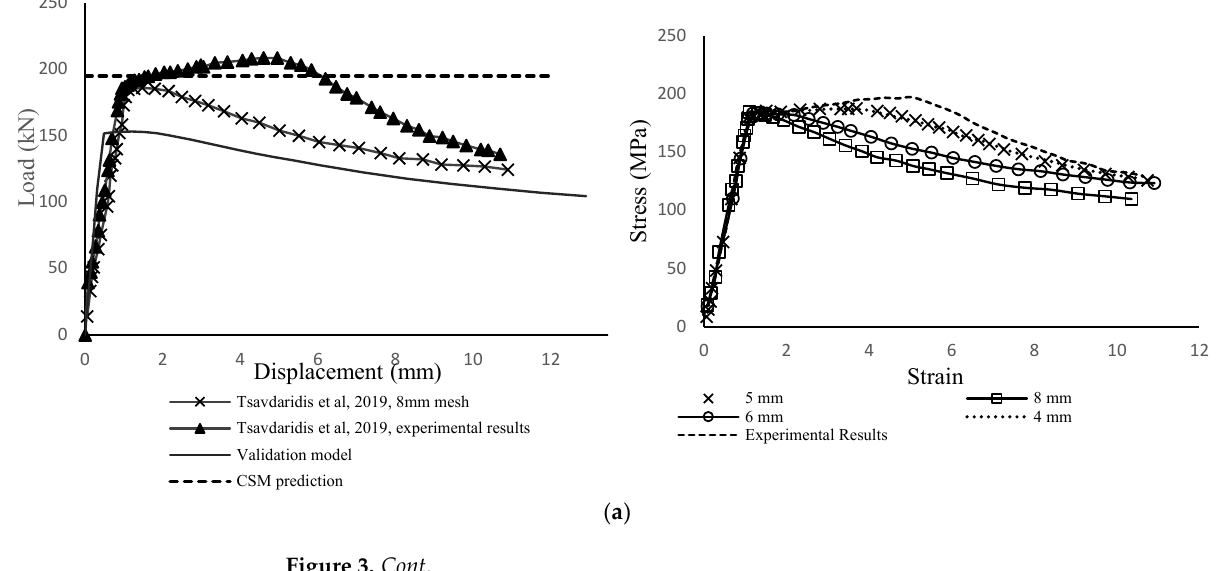
( b ) Figure 3. Validation analyses: ( a ) load – displacement curves — SV1 ( left ), load – displacement curves for various mesh sizes [1] ( right ). ( b ) Stress – strain curve — SV1 (up), stress – strain curve — SV2 (down). For the CSM predictions, the equations that were used, as given by Su et al. [16], are provided below. Initially, the cross-section slenderness, λ p , was determined. The cross- section slenderness is a non-dimensional form acquired by the square root of the ratio of the yield stress f y to the elastic buckling stress σ cr of the cross-section, as can be seen in Equation (1). All the cross-sections investigated in this paper were non-slender, since their cross-section slenderness, λ p , was lower than 0.68. In this study, the elastic buckling stress was calculated through a formula acquired from Seif and Schafer [36], as shown in Equa- tion (2). Thereafter, the cross-section deformation capacity needs to be determined, which is expressed as the ratio of the CSM-predicted level of strain, ε csm , to the yield strain, ε y . This is given by a prediction provided in Su et al. [16], which is accurate for aluminium alloy profiles, both stocky and slender, as shown in Equation (3). In addition, the strain hardening slope was calculated by Equation (4), which employs the yield and ultimate strength as well as the yield and ultimate strain, f y , f u , ε y , and ε u , respectively. C2 is the proportion of ultimate strain and is assumed to be 0.5, which corresponds to an